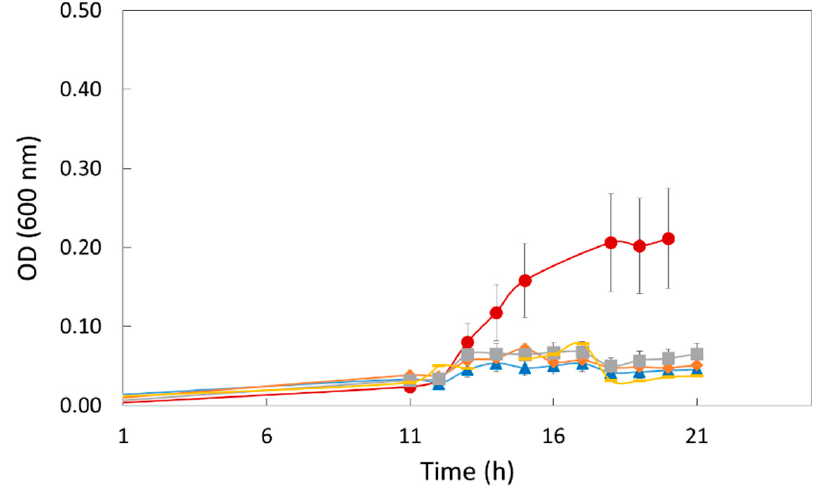
Figure 3. Growth curve of Campylobacter spp. at 41.5 °C: ● no films; ▲ CH 2% films; ♦ CH 2% + OLE 10% films; ■ CH 2% + OLE 20% films; -- CH 2% + OLE 30% films. Overall these results are consistent with findings from other authors that concluded that OLE has not a broad-spectrum of antimicrobial activity, but shows appreciable